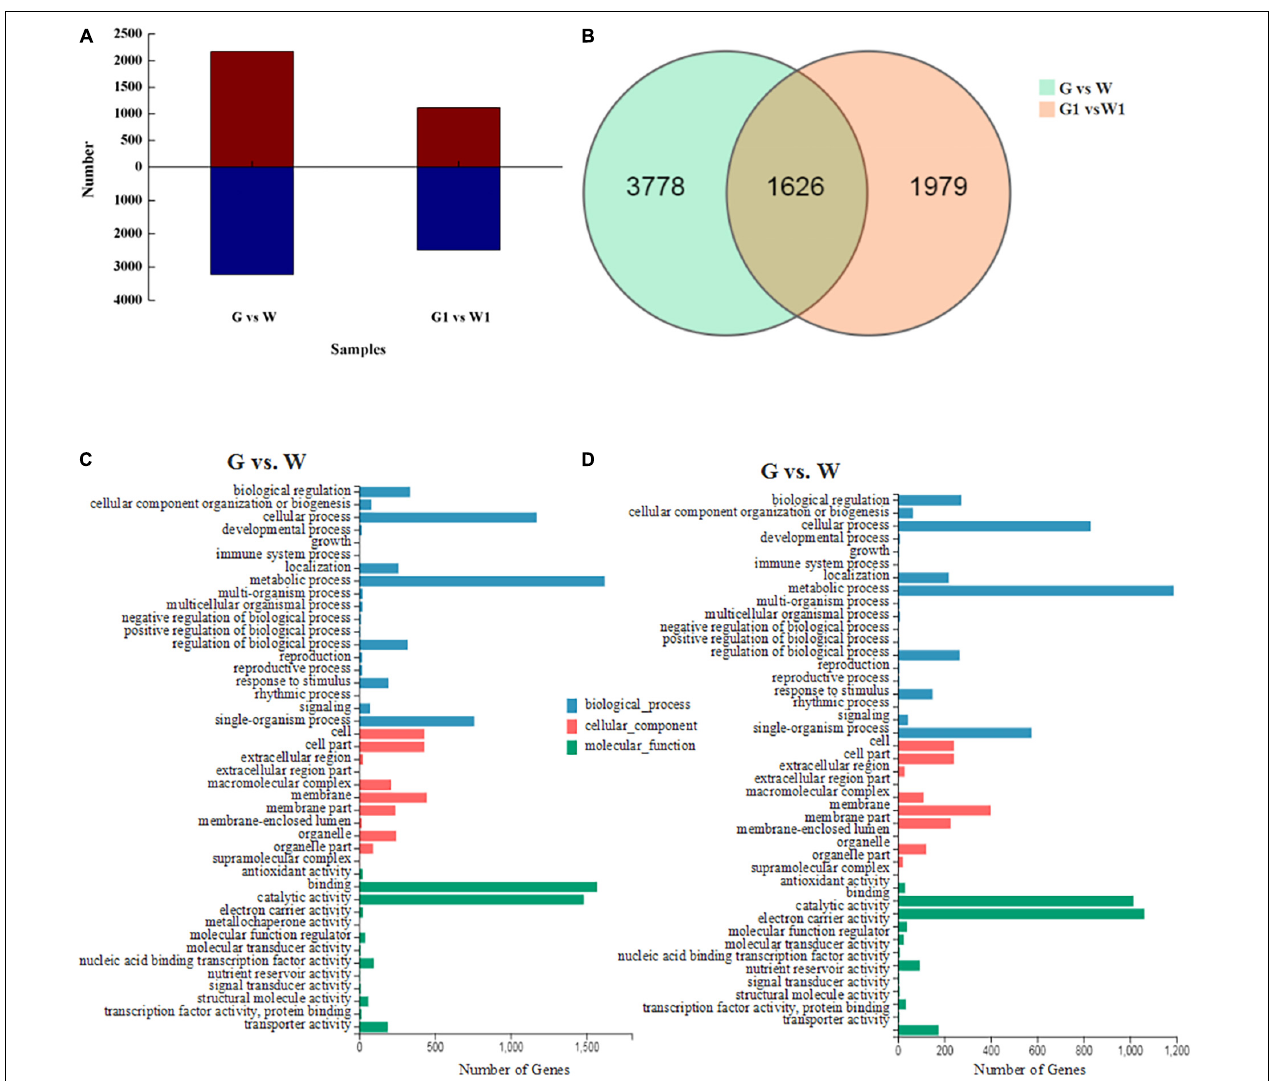
FIGURE 2 | (A) Numbers of up- and downregulated DEGs identified in pairwise comparisons. Red, upregulated DEG; blue, downregulated DEGs. (B) Venn diagram of DEGs identified by pairwise comparisons. GO classifications of DEGs in the (C) G vs. W and (D) G1 vs. W1 comparisons.